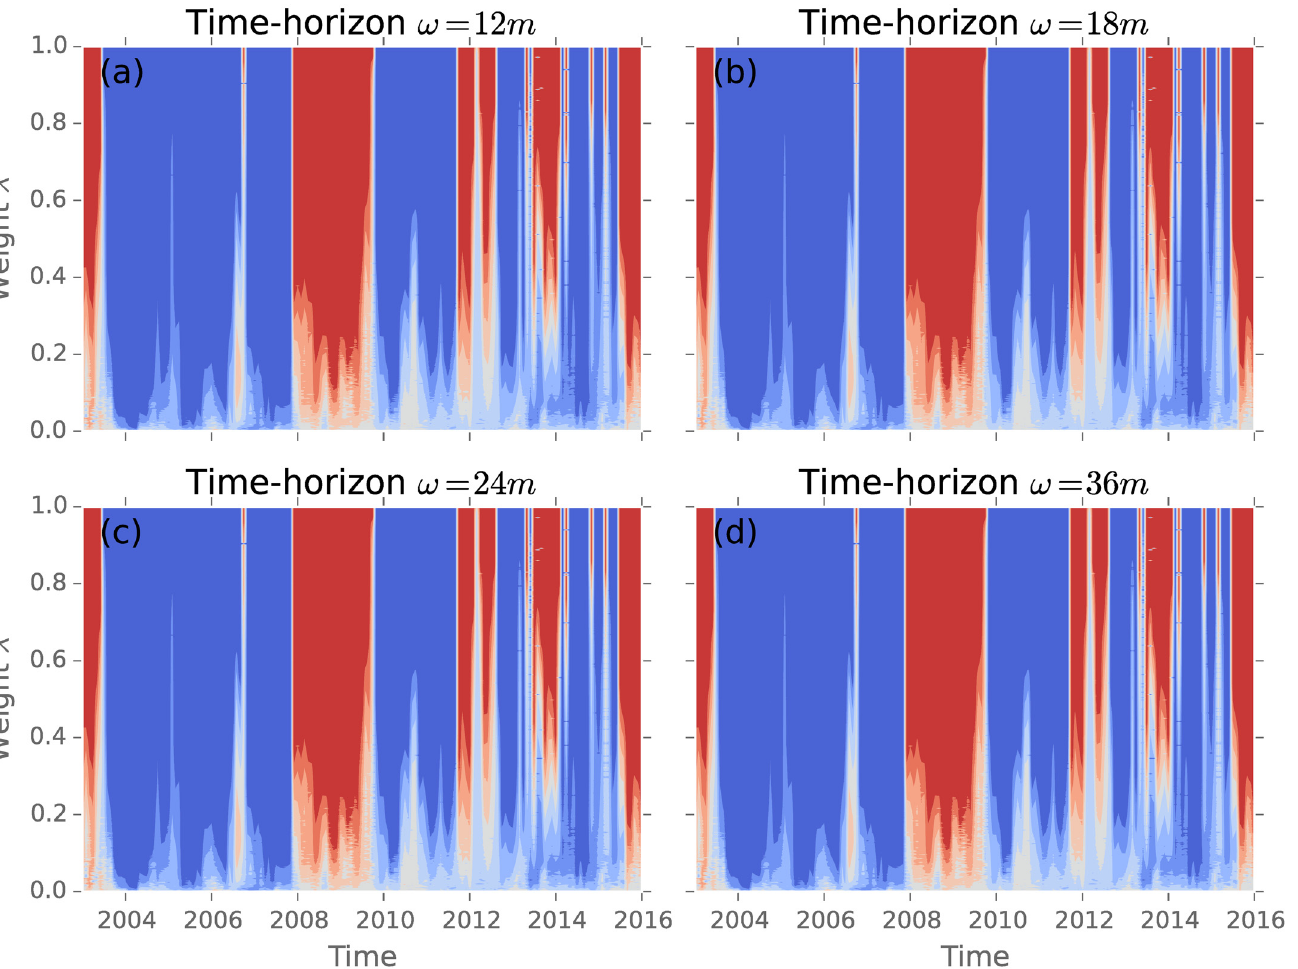
Fig 1. The investing strategies calculated for different time-horizons from January 2003 until January 2016. (a) ω = 1 year; (b) ω = 18 months; (c) ω = 2 y and (d) ω = 3 y ; Blue signals a majority of positive portfolio weights, while red is related to dominantly negative weights in the solution. In all time-windows (a)-(d) the global financial crisis is depicted with negative